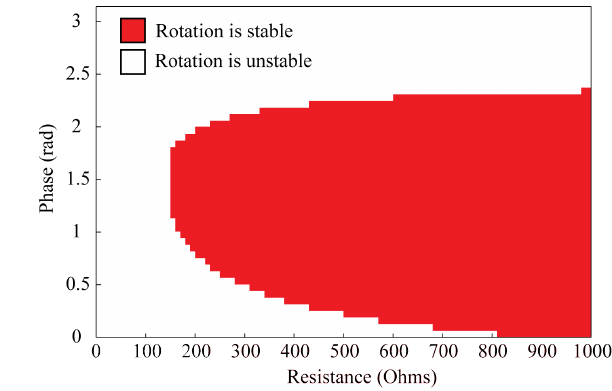
Figure 12. Simulated motor speed with respect to frequency and time.